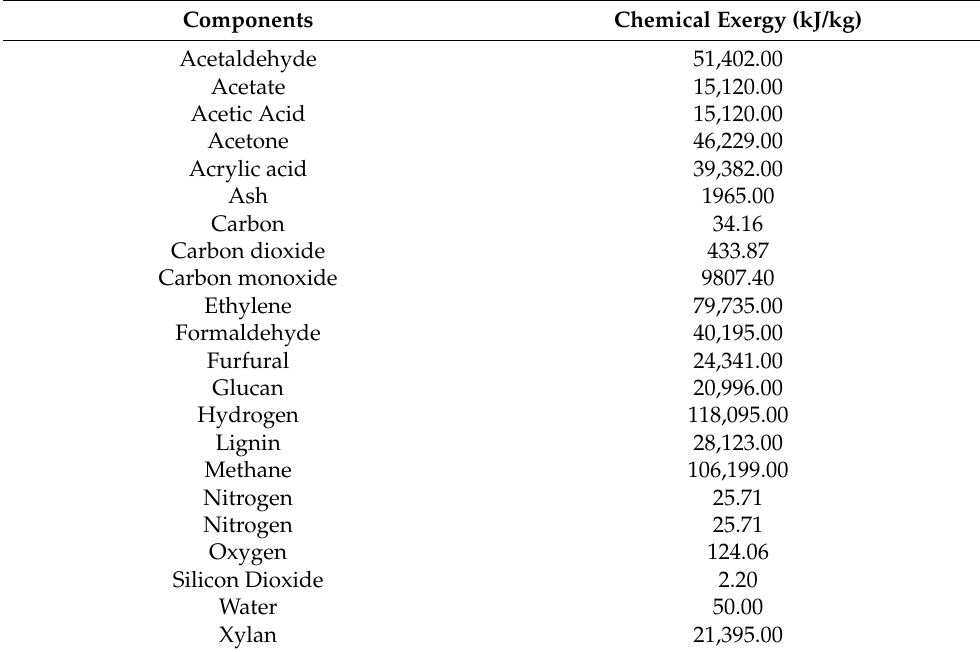
Table 4. Chemical exergy of active components.